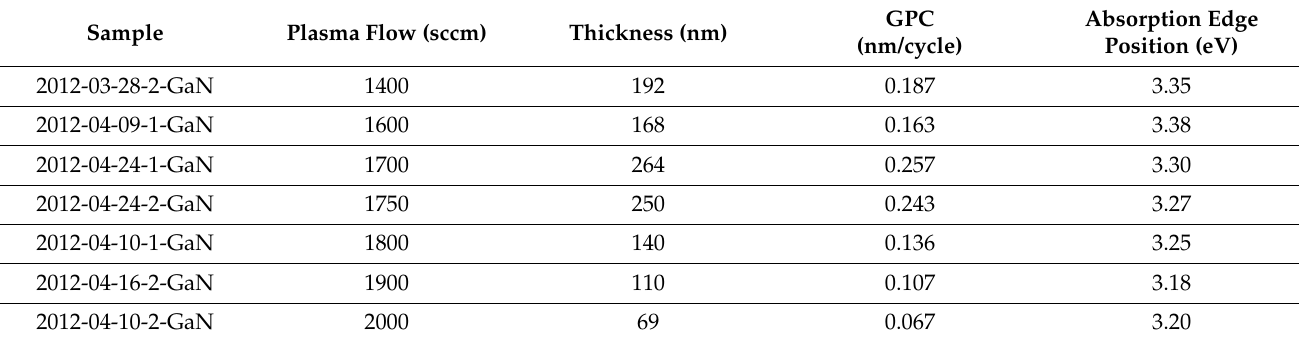
Table 2. Table showing film thickness and absorption edge data for this less gallium-rich growth series. Thickness measurements were based on SEM